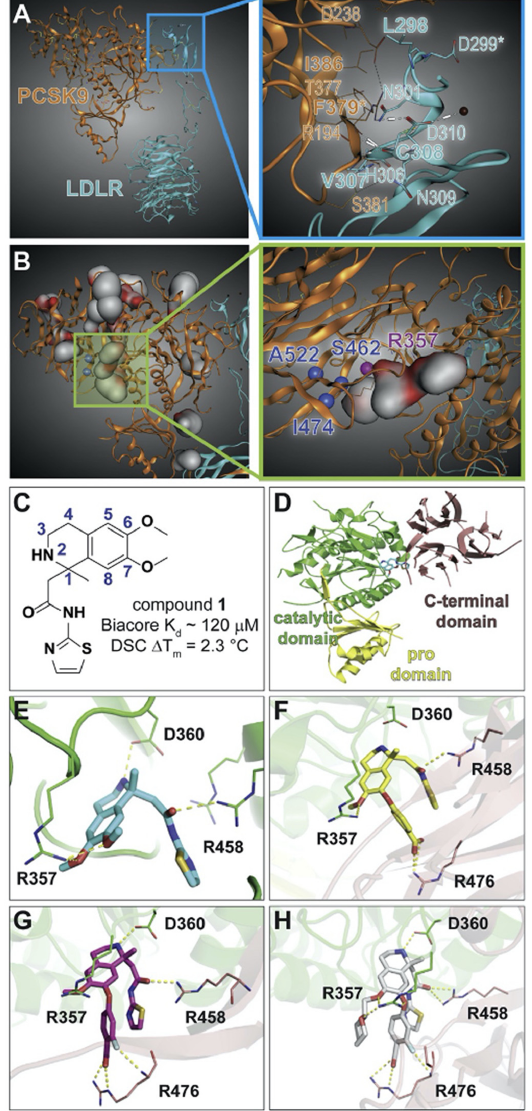
Figure 4. PCSK9/LDLR complex crystal structures with multiple small molecule ligands (Petrilli, W.L. et al., 2020 [59]). ( A ) Binding interface of PCSK9 (orange) and LDLR (sky-blue) (PDB ID